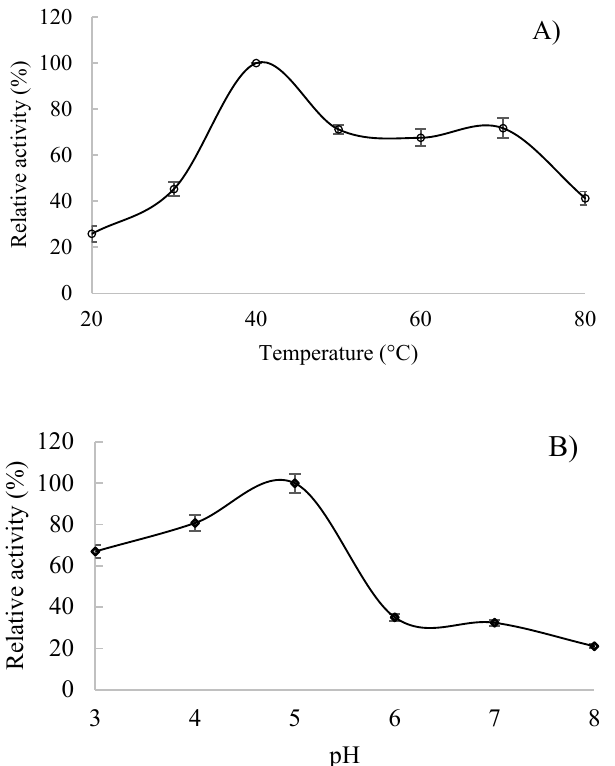
Figure 3. Physical characterization of α - L -arabinofuranosidase. ( A ) Effect of temperature on EAH activity and ( B ) Effect of pH on EAH activity. Mean and standard deviations were plotted.